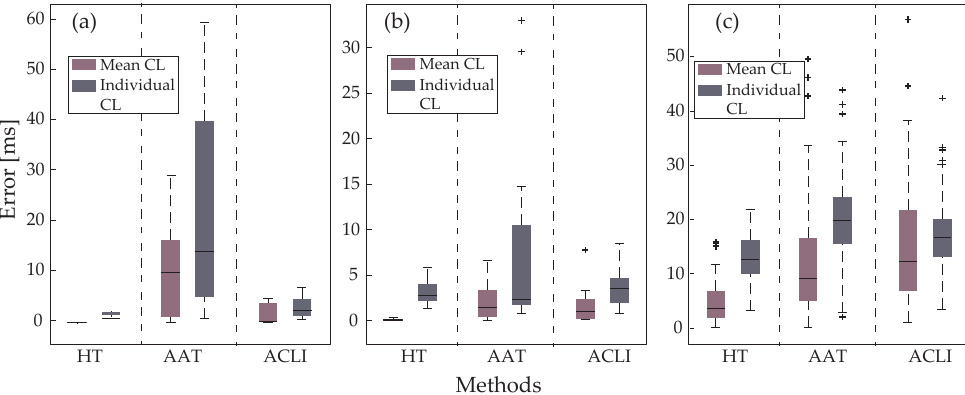
Figure 5. Comparative analysis of errors estimating CL using the mean CL and the individual CL methods for the three LAW detectors compared: ( a ) Results for type I electrograms; ( b ) type II electrograms; and ( c ) type III electrograms. Values indicated with + stand for outliers.